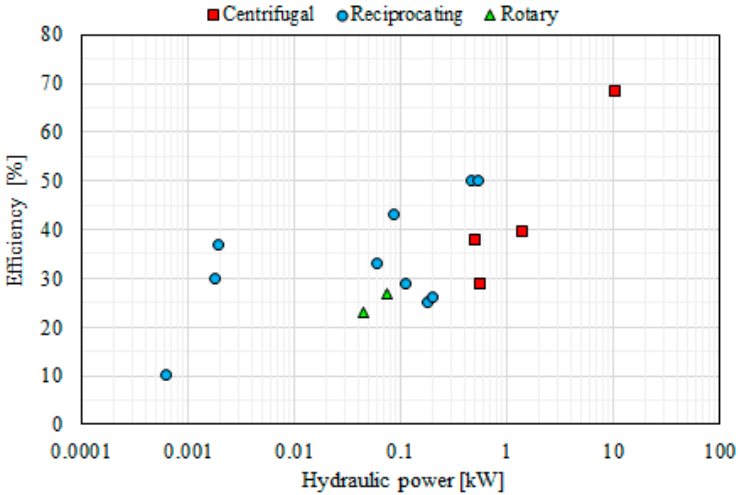
Figure 3. Reported pump maximum efficiency and hydraulic power in the literature up to 2017 based on data from [11].